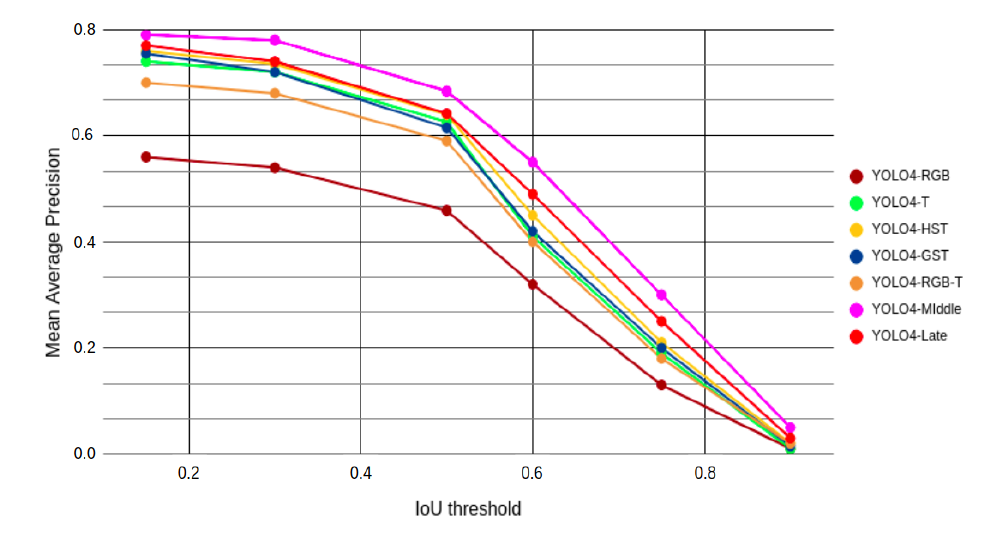
Figure 6. Measured mAP for different IoU threshold values for all considered fusion